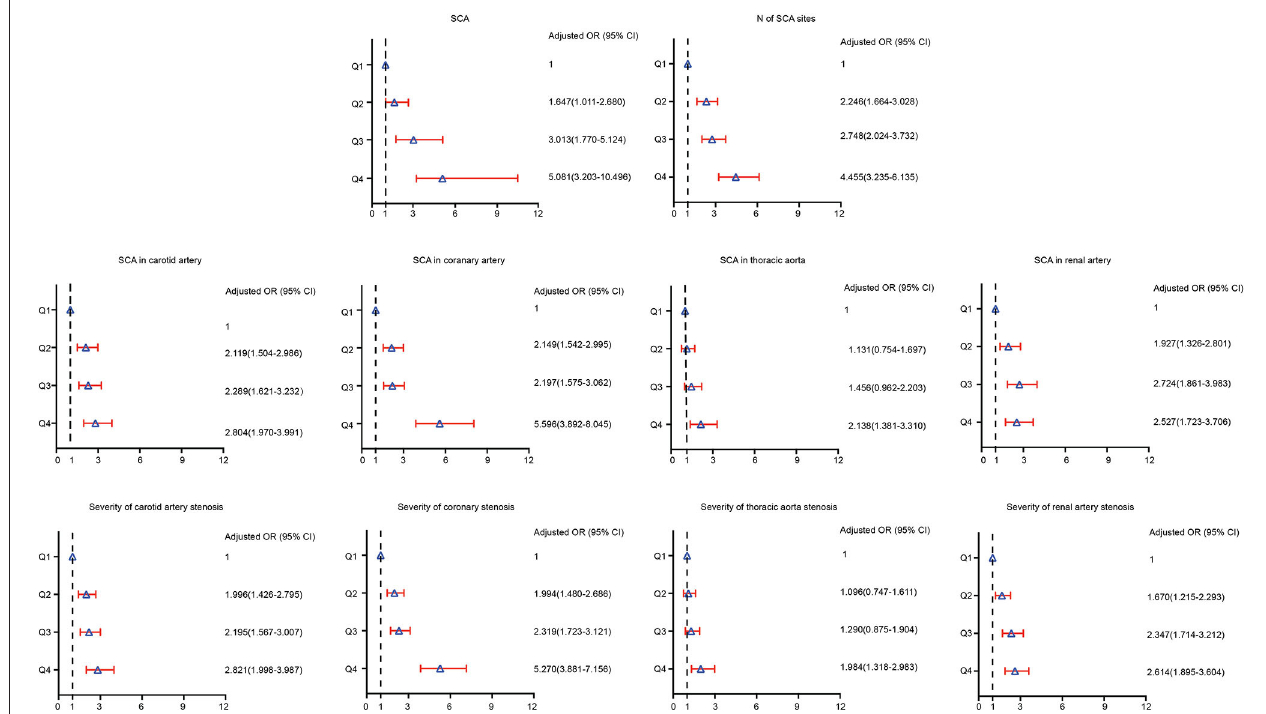
FIGURE 2 | Risk of prevalence and severity of SCA according to baseline serum uric acid quartiles in adjusted models.